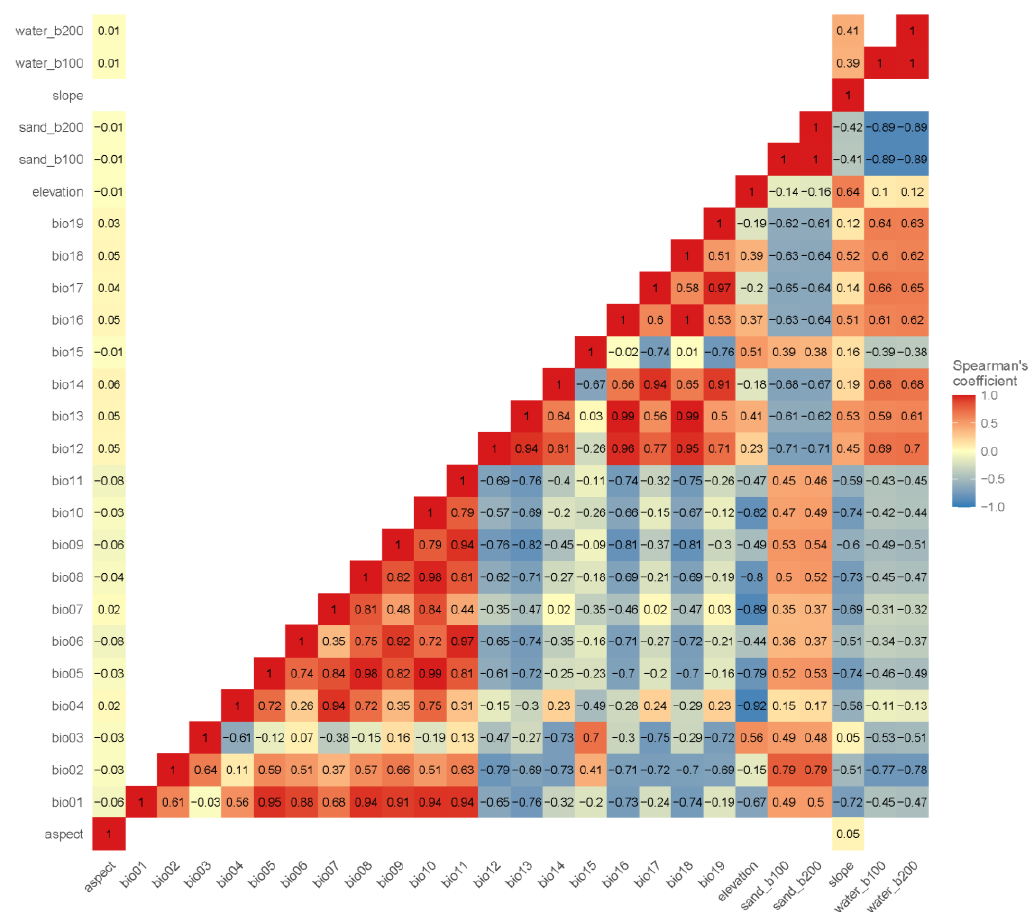
Figure A1. The figure of the correlation matrix of all variables.